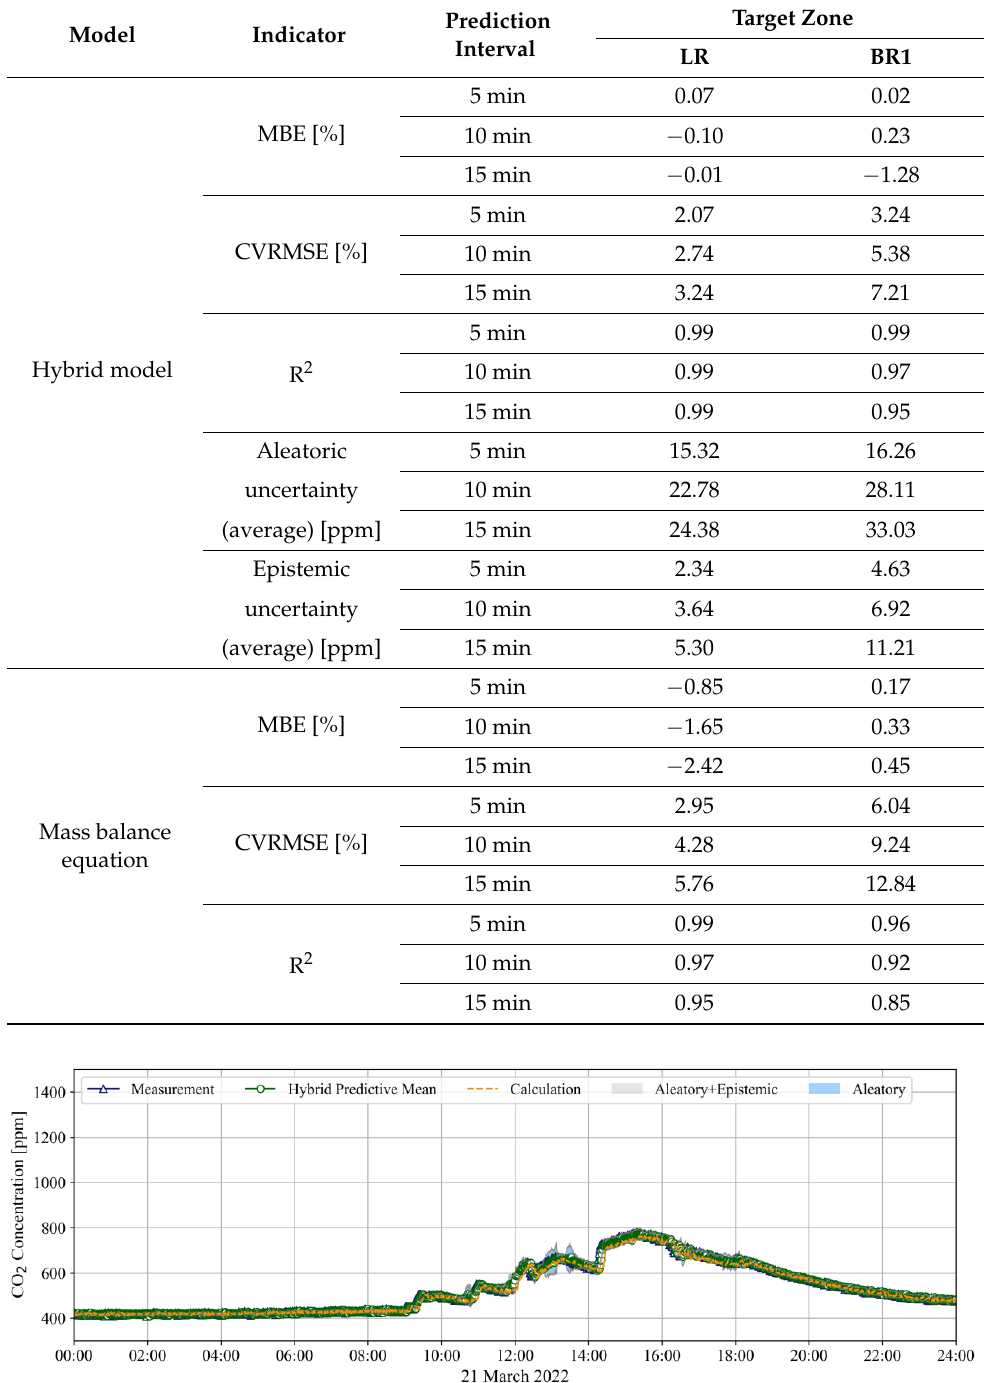
Table 3. Forecasting accuracy and uncertainty results.